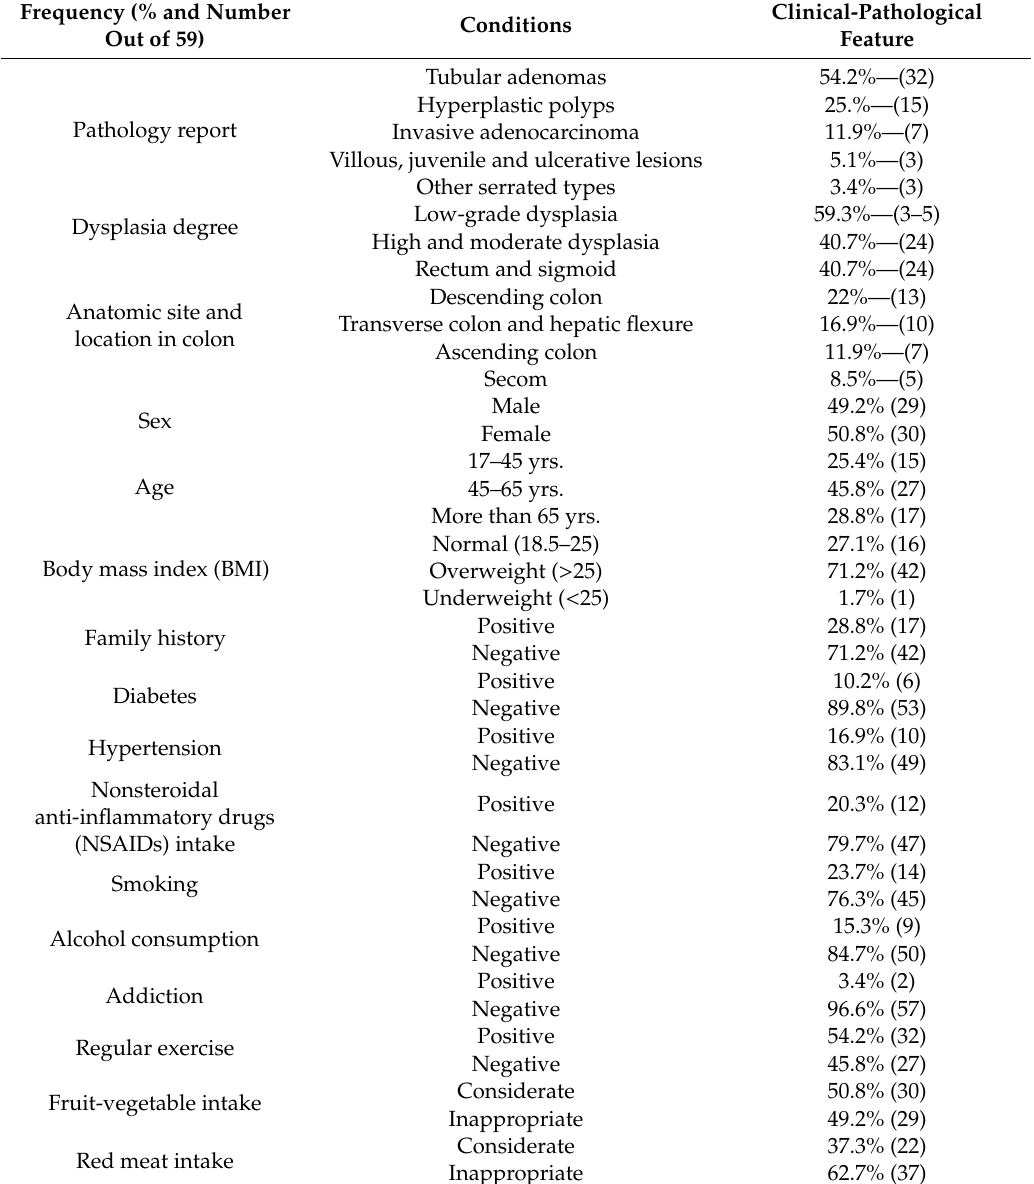
Table 4. Frequency of the clinic-pathological features of the